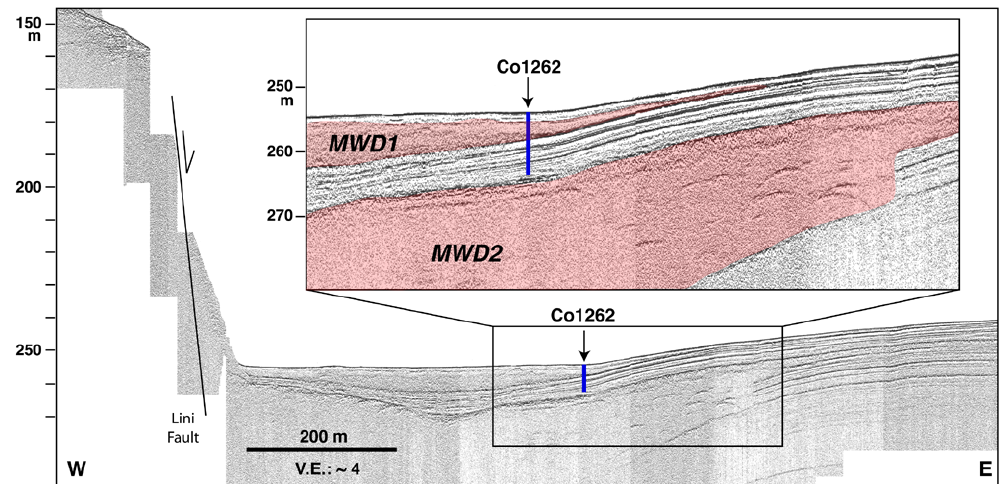
Fig. 3. Uninterpreted and interpreted (insert) hydro-acoustic profile in front of the Lini peninsula (see Fig. 1 for exact location). The profile was obtained with an Innomar transducer. The blue bar indicates the coring location Co1262 and transparent sediment bodies (red coloured in the interpreted insert) indicate mass wasting deposits (MWD1 and MWD2).